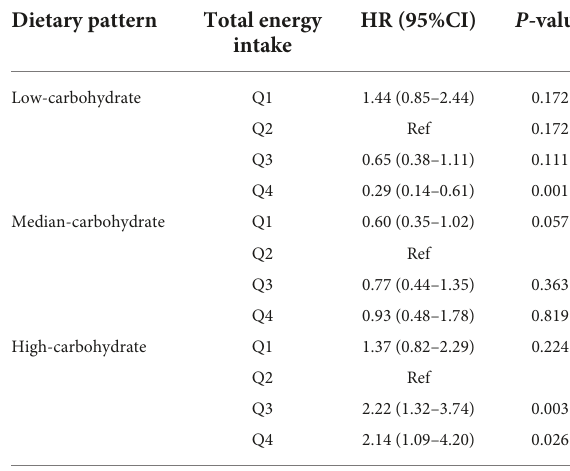
TABLE 3 Hazard ratio of all-cause death based on dietary